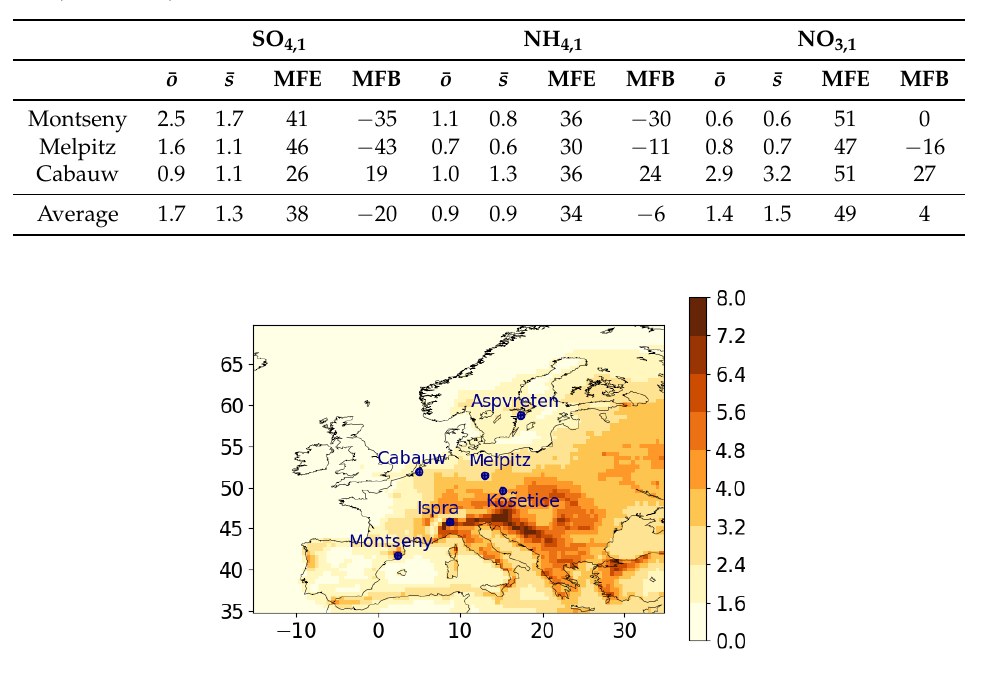
Figure A1. Map of OM 1 concentrations ( µ g m − 3 ) averaged between 1 June 2012 and 30 August